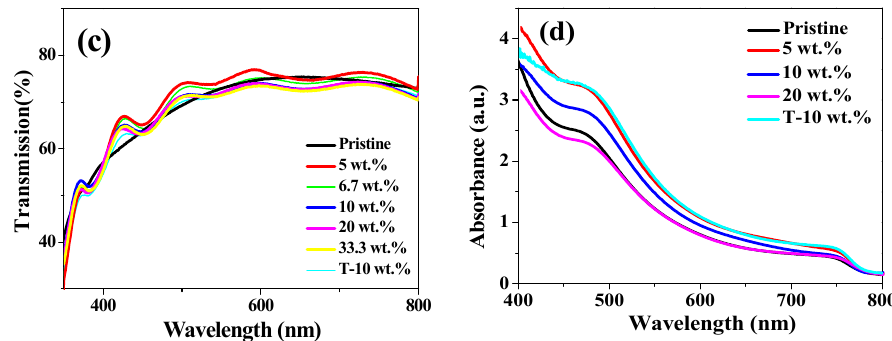
Figure 6. ( a ) The transmission spectra of different substrates; ( b ) Haze curves of S-FTO and T-FTO substrates; ( c ) The transmission spectra of various Ag NPs wt.% from 0 to 33.3% in TiO 2 films on S-FTO and T-FTO; ( d ) UV-vis absorbance data of FTO/ with or without Ag NPs concentration embedded in c- TiO 2 /m-TiO 2 / CH 3 NH 3 PbI 3.